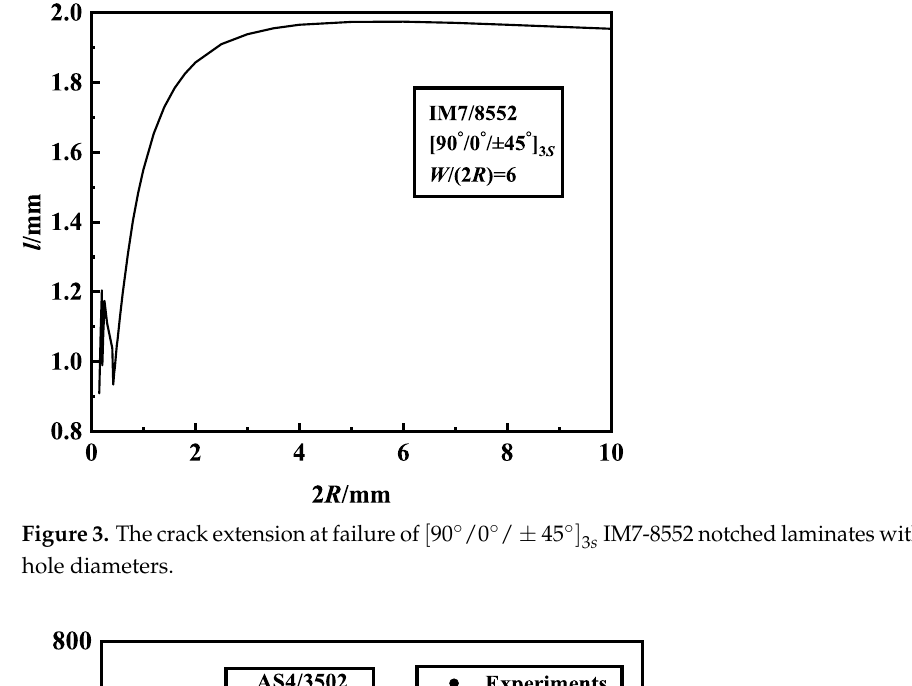
IM7-8552 notched laminates with varying 3 s